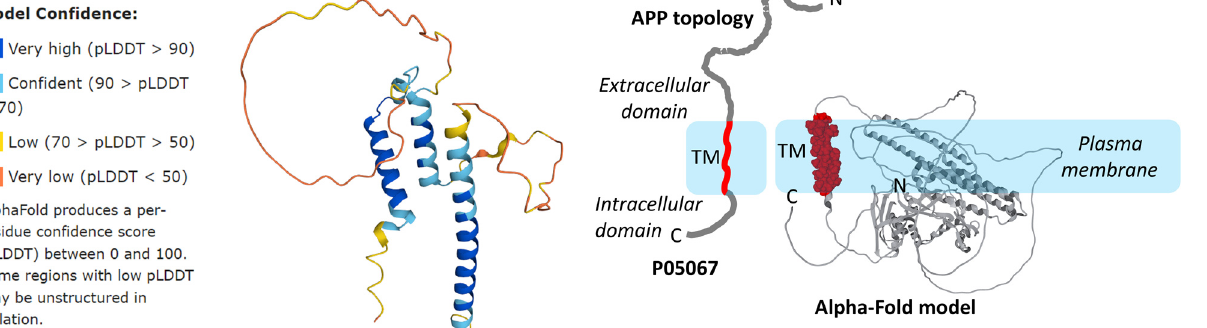
Figure 1: Example of AlphaFold structure. AlphaFold model of Mid1 - interacting protein 1 downloaded from Uniprot #Q9NPA3. The con - fi dence of the pLDDT is indicated by a color code.